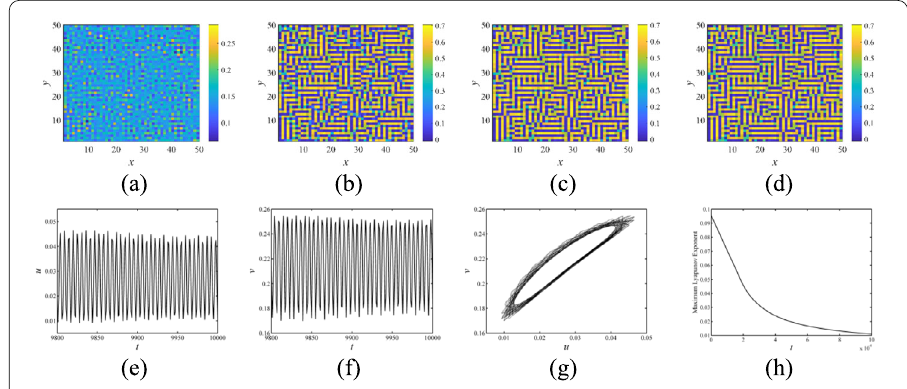
Figure 5 Self-organziation and nonlinear properties of a labyrinth pattern when the parameter values are given as a = 1.1, e 1 = 0.3, e 2 = 0.2, b = 0.38, τ = 2.5, δ = 10, h = 15, n = 50. ( a )–( d ) Evolution of the prey pattern at transient times t = 10, t = 30, t = 100, and t = 1000, respectively; ( e )–( g ) wave diagrams, phase portrait and maximum Lyapunov exponent diagram which present same nonlinear properties like in Fig. 3